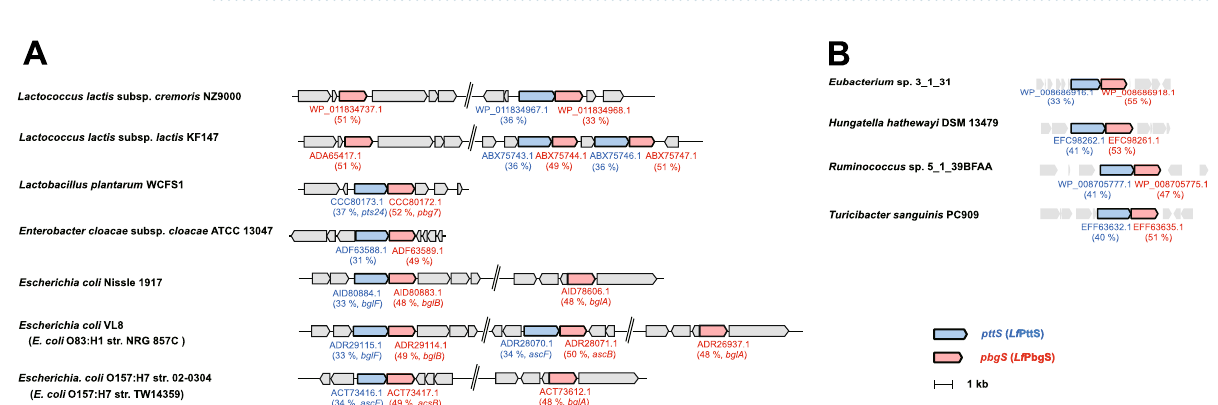
Figure 5. Distribution of gene clusters containing pttS and pbgS homologues in bacteria. Genes encoding homologues of Cf PttS and Cf PbgS are indicated in blue and red, respectively. The NCBI accession number assigned to each gene encoding a Cf PttS or Cf PbgS homologue and its sequence identity obtained by BLASTP analysis as well as its gene symbol are presented below its coding region. Sequence identities are presented in brackets below the coding regions. ( A ) The homologues of pttS and pbgS in GSL-degrading bacteria. GSL- degrading activities of all bacteria listed above were confirmed in the present study or in previous studies 15–17 . The strains written in parenthesis were used as genome reference in the previous study. ( B ) The homologues of pttS and pbgS in gut bacteria. All bacteria listed are gut bacteria whose genomic sequences were obtained by metagenomic sequencing of gut microbiome in the Human Microbiome Project 18